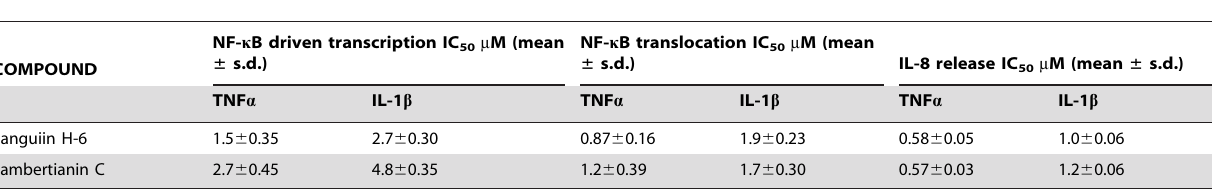
Table 1. Effect of individual compounds sanguiin H-6 and lambertianin C on NF- k B pathway in human gastric epithelial AGS cells.